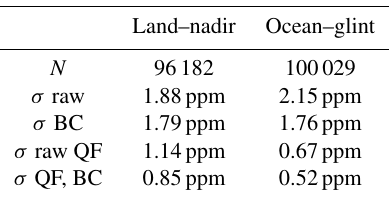
Table 5. Comparison of the standard deviation ( σ ) in XCO 2 before and after QF and